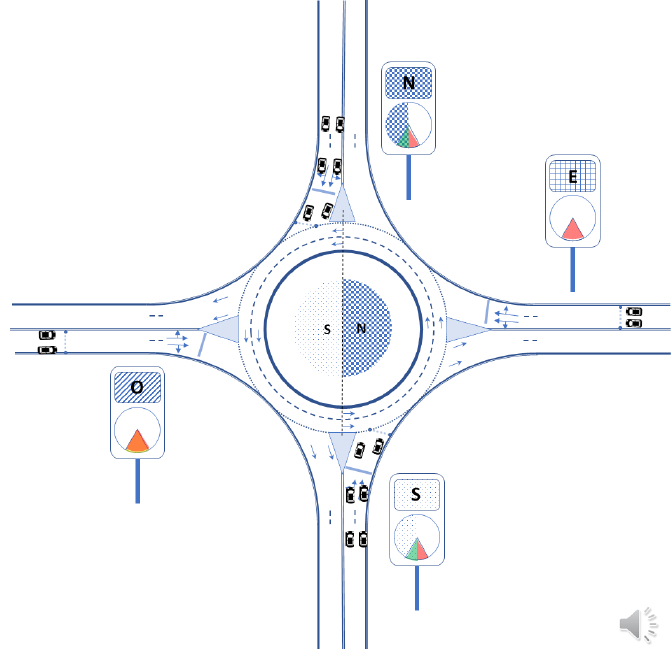
Figure 1. An example of a synchronous revolving roundabout with rotating priorities and staggered